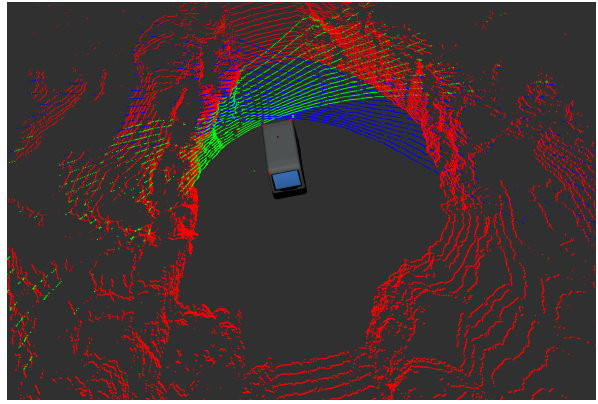
Figure 9. LiDAR configuration